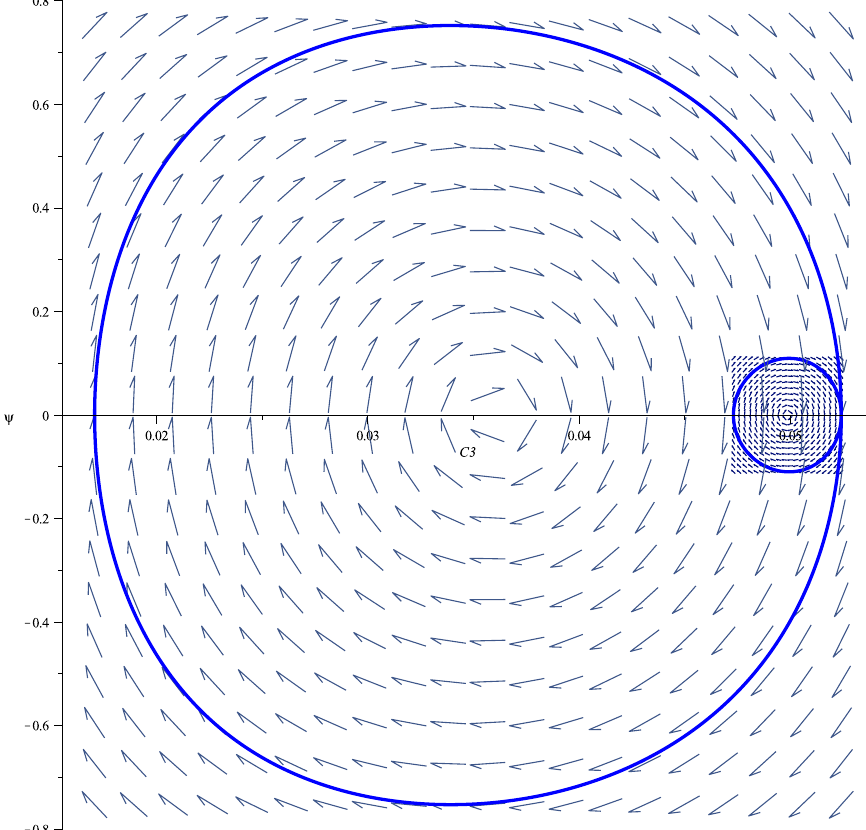
Figure 6. Simultaneous plot of two phase portraits and integral curves for the detunings ∆ ω = ± 0.1 shown at Figures 4a and 5a